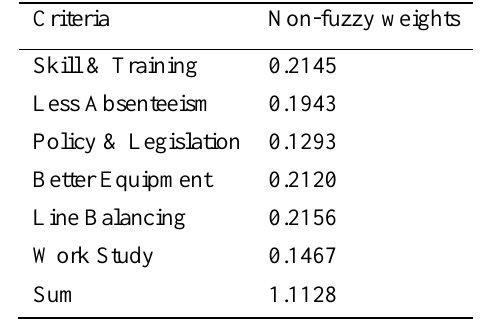
Table 5. Relative non-fuzzy weight of each